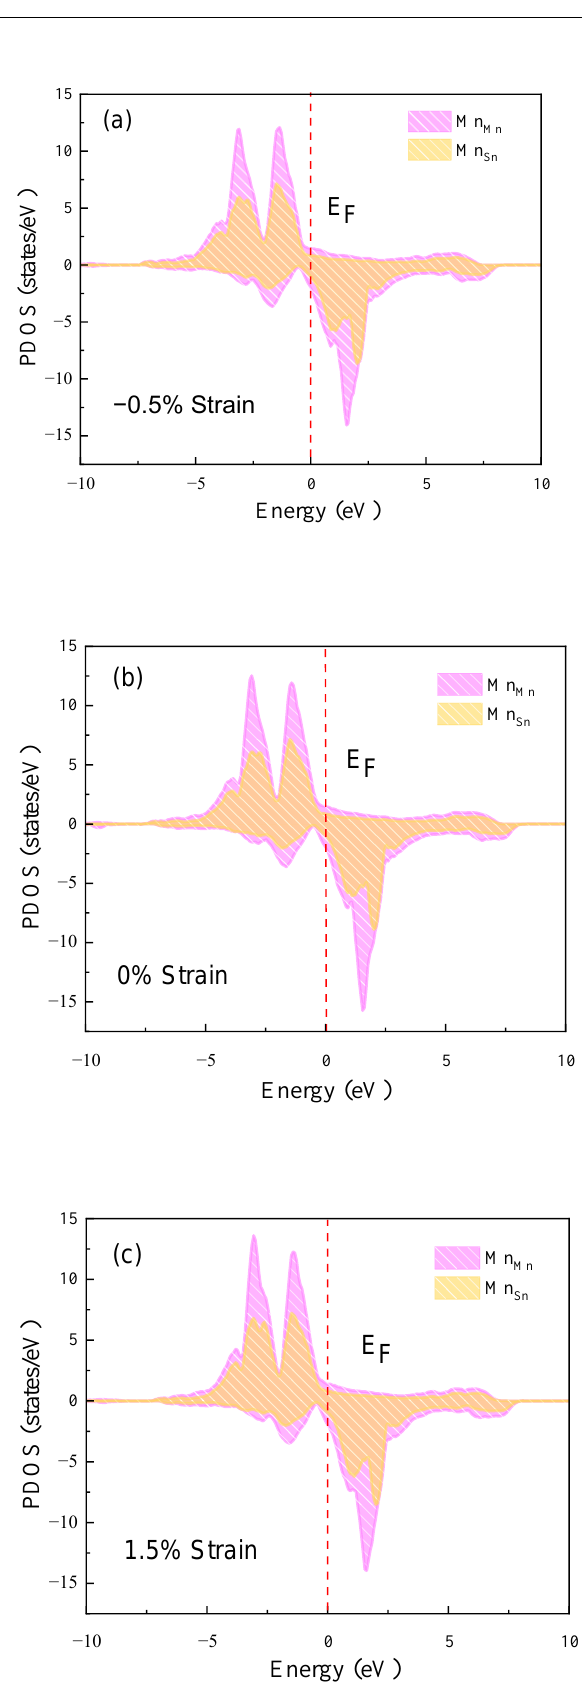
Figure 8. Strain change ( − 1.5%, 0%, 1.5%) of the PDOS of Ni 14 Co 2 Mn 13 Sn 3 austenitic phase. ( a ) − 1.5% strain, ( b ) 0% strain, ( c ) 1.5% strain.